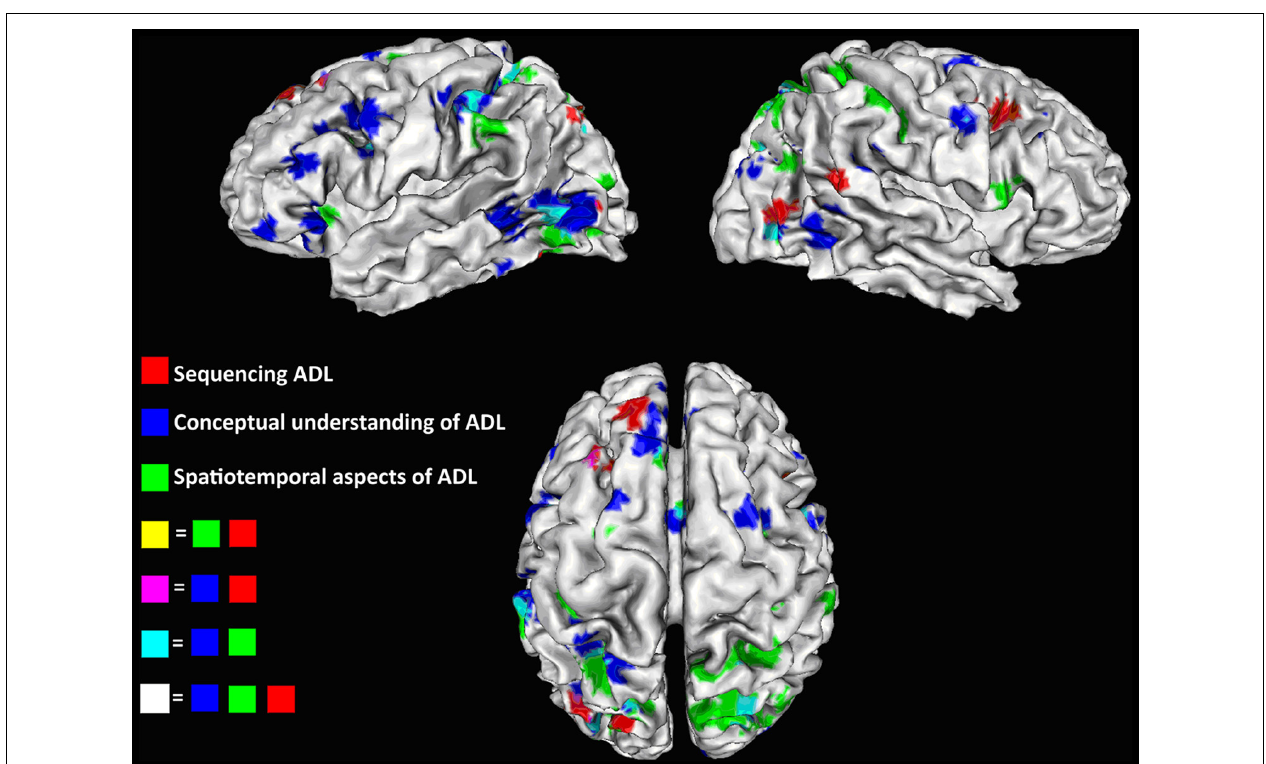
FIGURE 1 |ALE images for studies focusing on action sequencing in red, conceptual understanding ofADL in blue, and spatial orientation ofADL in green; Overlays are depicted in purple (blue + red), light blue